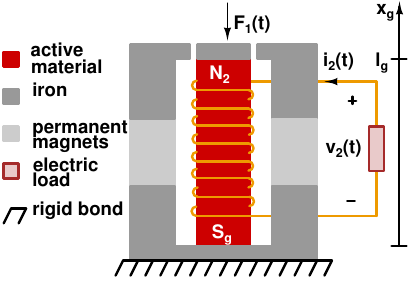
Figure 4. 2-D sketch of a force driven magnetostrictive KEH concept device and its main